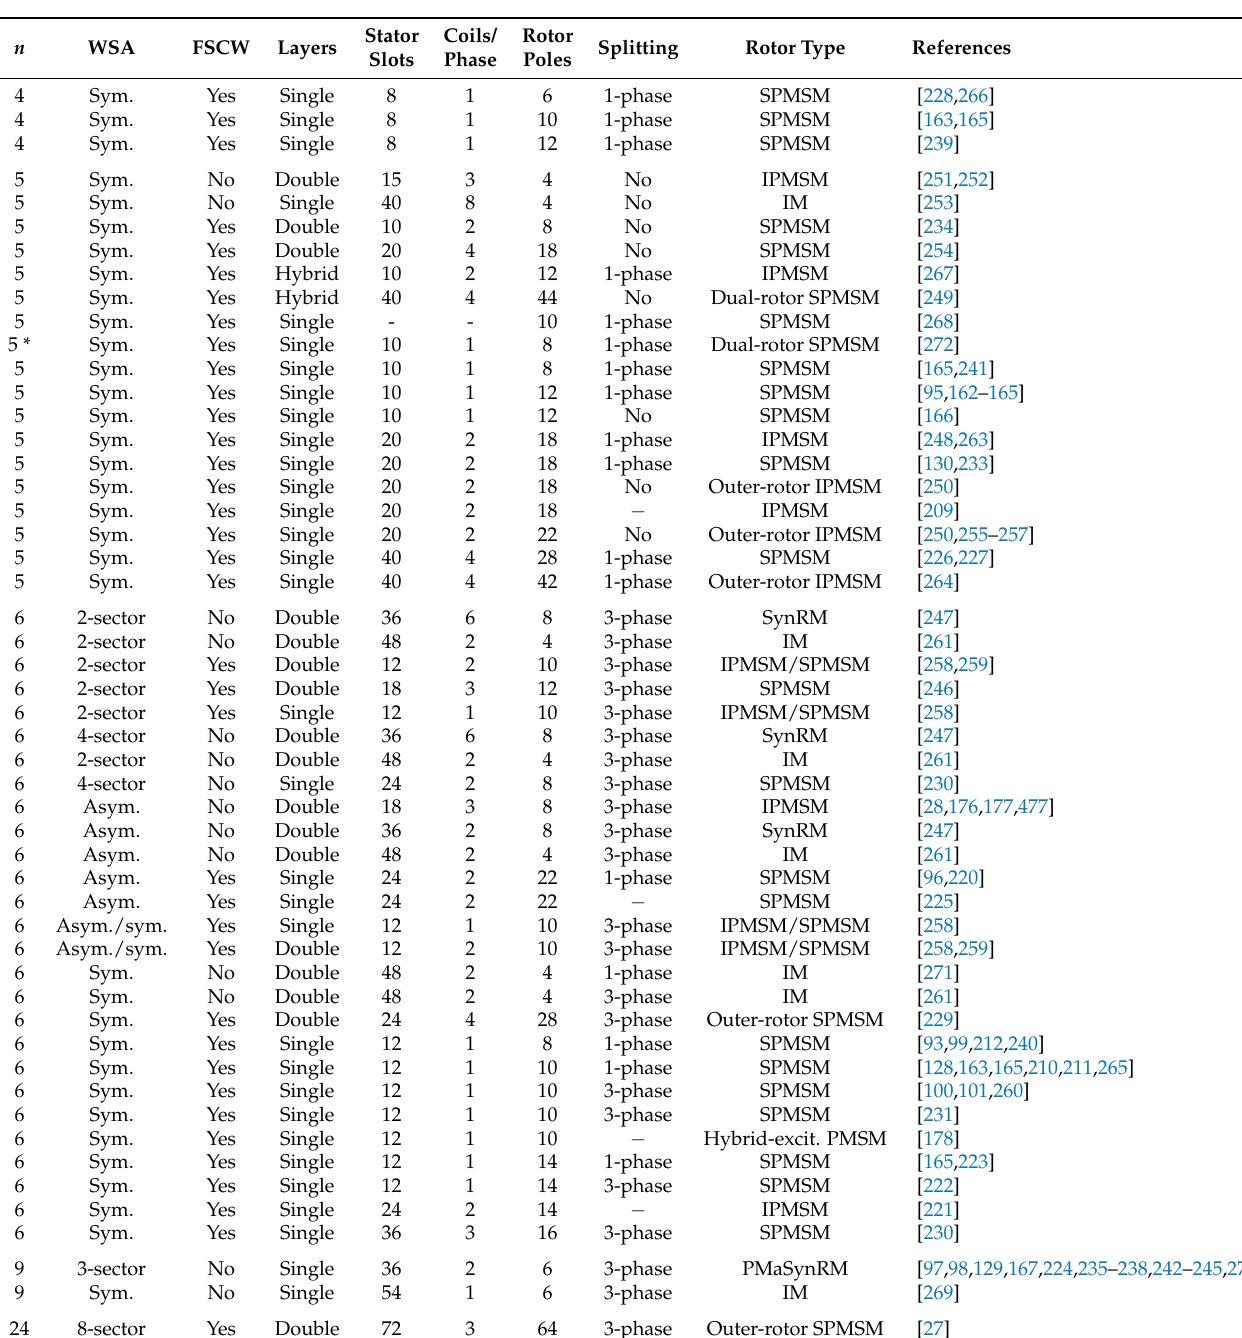
Table 10. Types of multiphase machines employed for tolerating stator SC faults (Section 5.3) in the